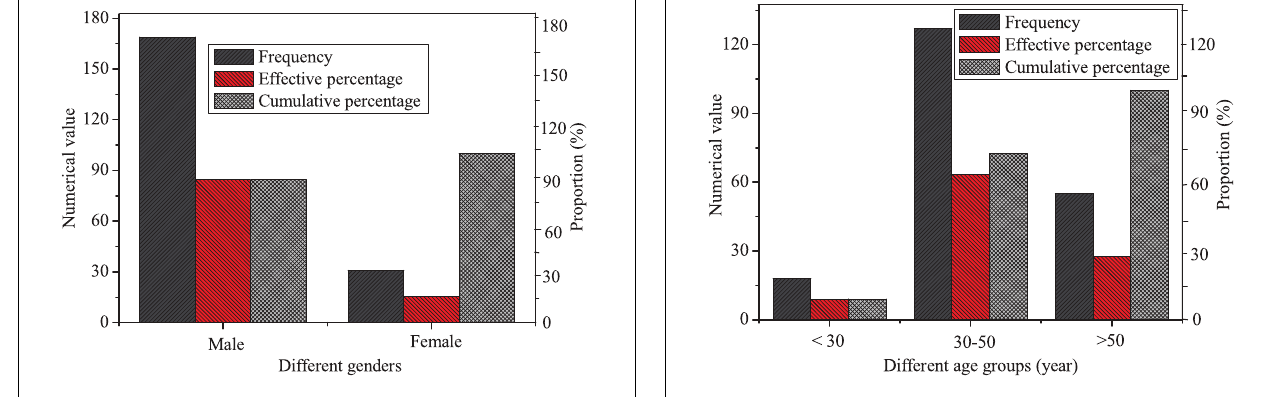
FIGURE 3 | Descriptive statistics of the genders of entrepreneurs. FIGURE 4 | Descriptive statistics of the ages of